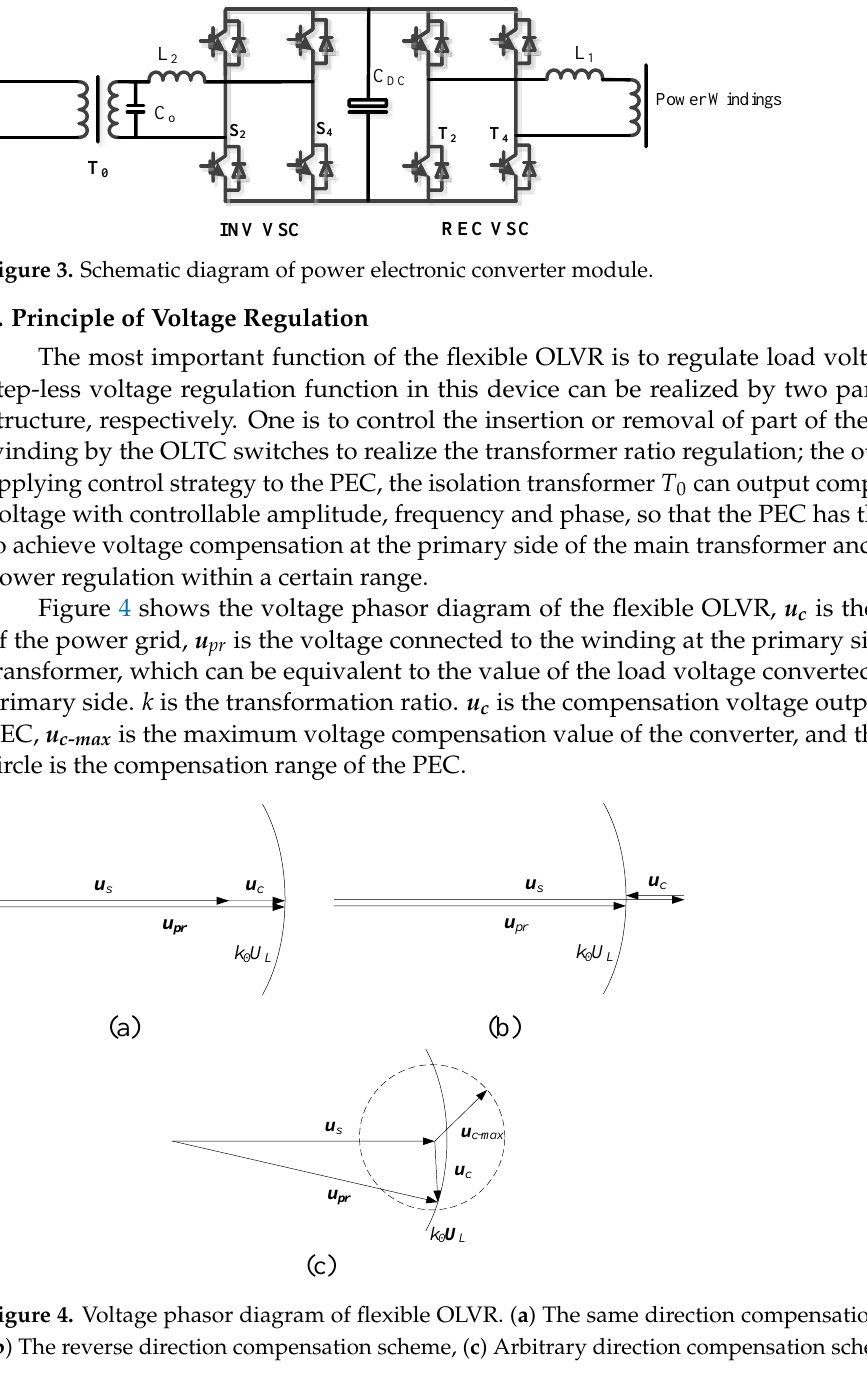
u po - Figure 5. Closed Loop Control Block Diagram of VSC at Rectifier Side. 3.3. Control of VSC at Inverter Side The VSC of the inverting side topology is also composed of a single-phase full-bridge inverter. The output of the VSC-I is filtered by Lc and isolated by transformer T 0 , then connected to the main circuit on the primary side of the transformer. The single-phase inverter is controlled by unipolar SPWM with a switch frequency of 10 kHz. Double closed loop control strategy is adopted in the VSC-I. Inductance current is the sum of load current and capacitance current, which can reflect the dynamic characteristics of the system to a certain extent. Therefore, inductance current is selected as the sampling